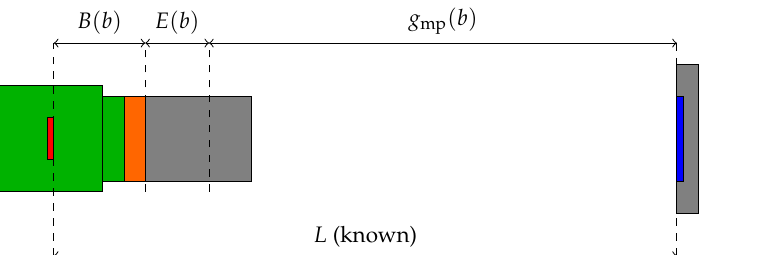
Figure 17. Schematic representation of the concept and the parameters used for